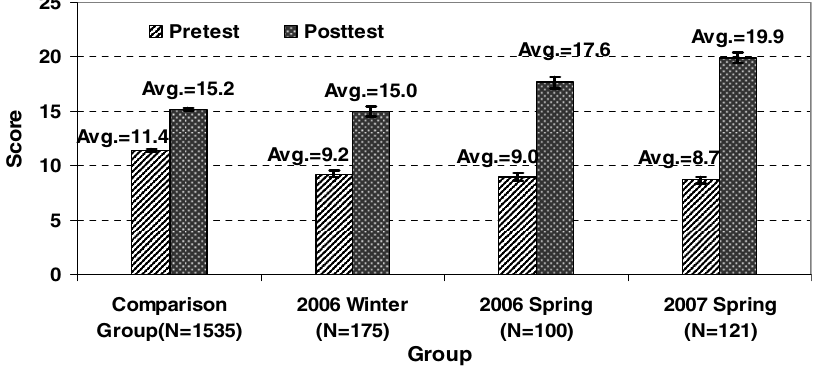
FIG. 4. Pretotal and Post-total scores of the comparison